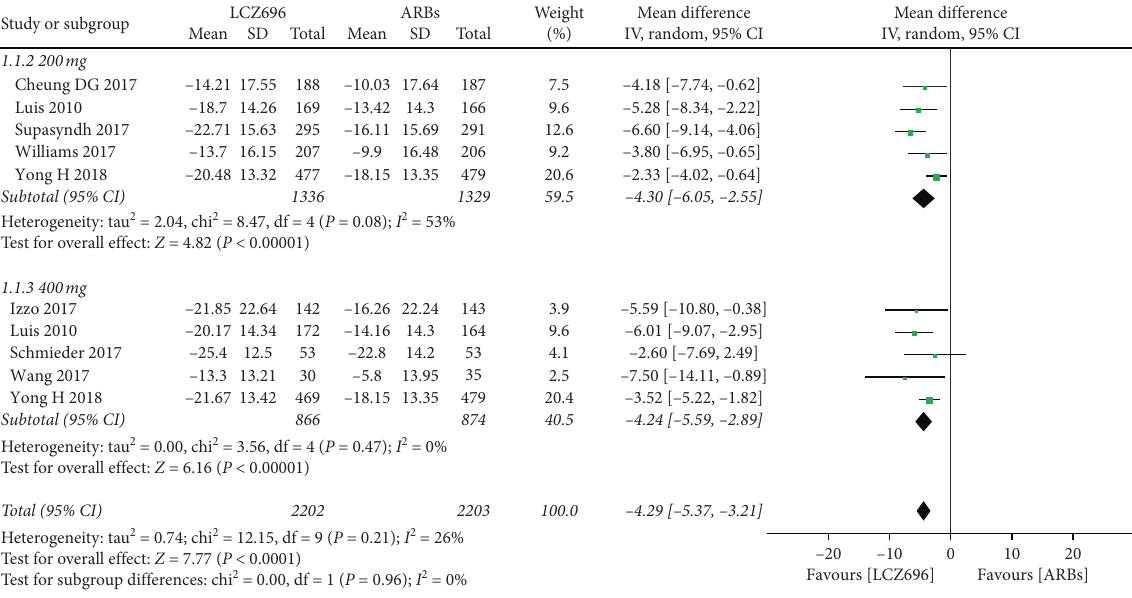
ARBs Mean difference